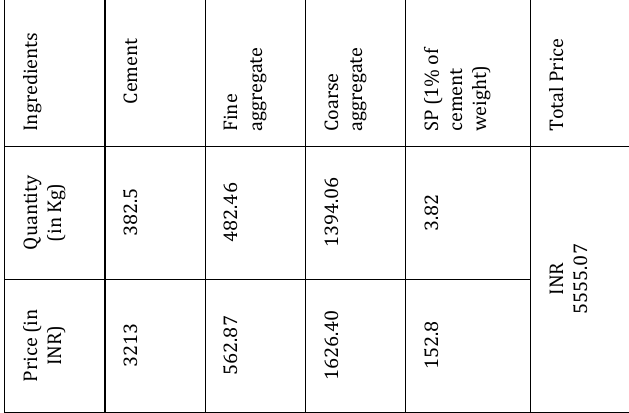
Table 7: Split tensile strength of cylinder